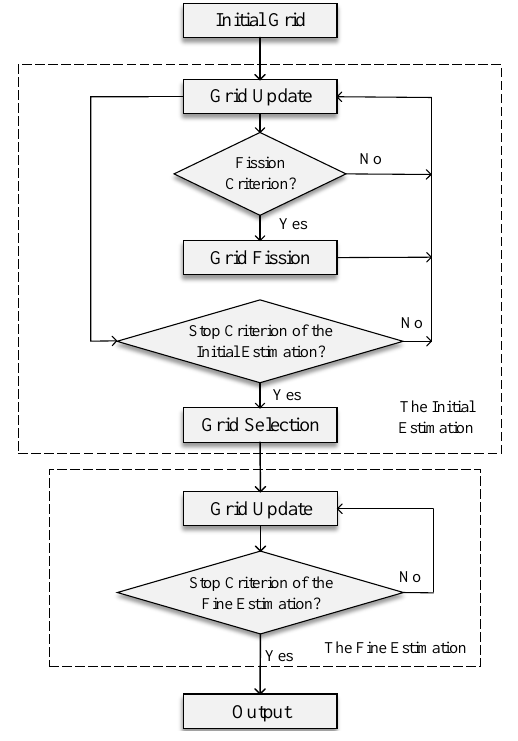
Figure 2. The flow chart of the proposed